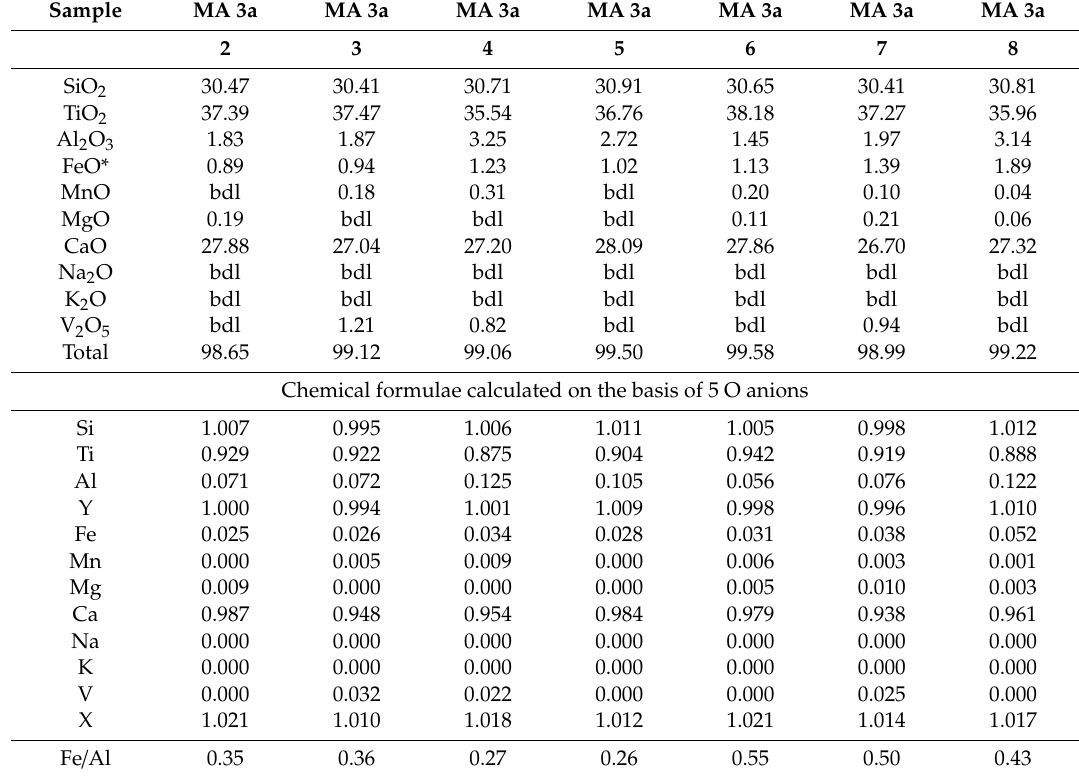
Table 7. Representative microanalyses (wt. %) and calculated formulae of hydrothermal titanite in the sodic-calcic alteration at Maronia. FeO*: total iron as FeO; bdl: below detection